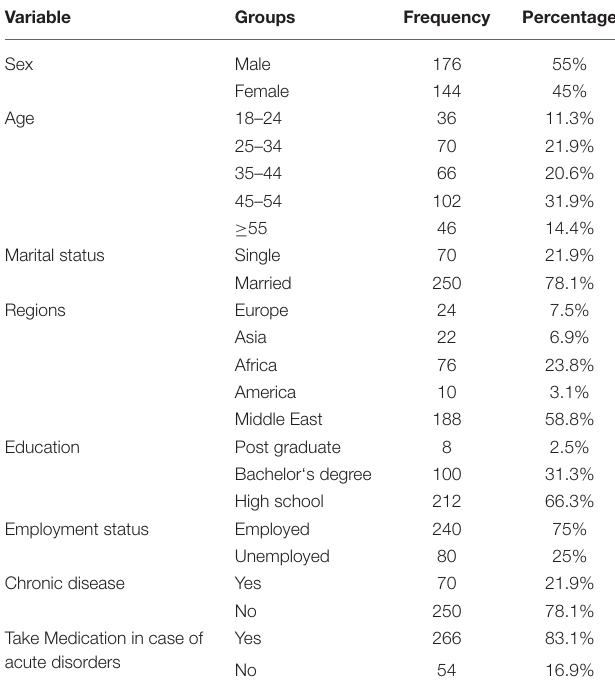
TABLE 1 | Frequency table for demographic characteristics ( n =